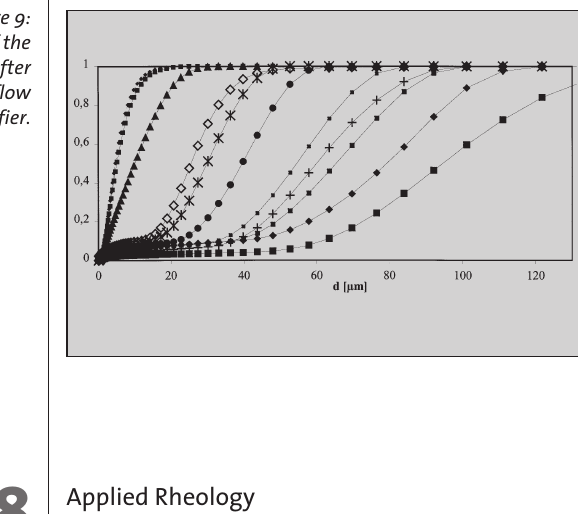
Figure 9: Sum distribution of the lactose-monohydrate after fractioning with a cross flow